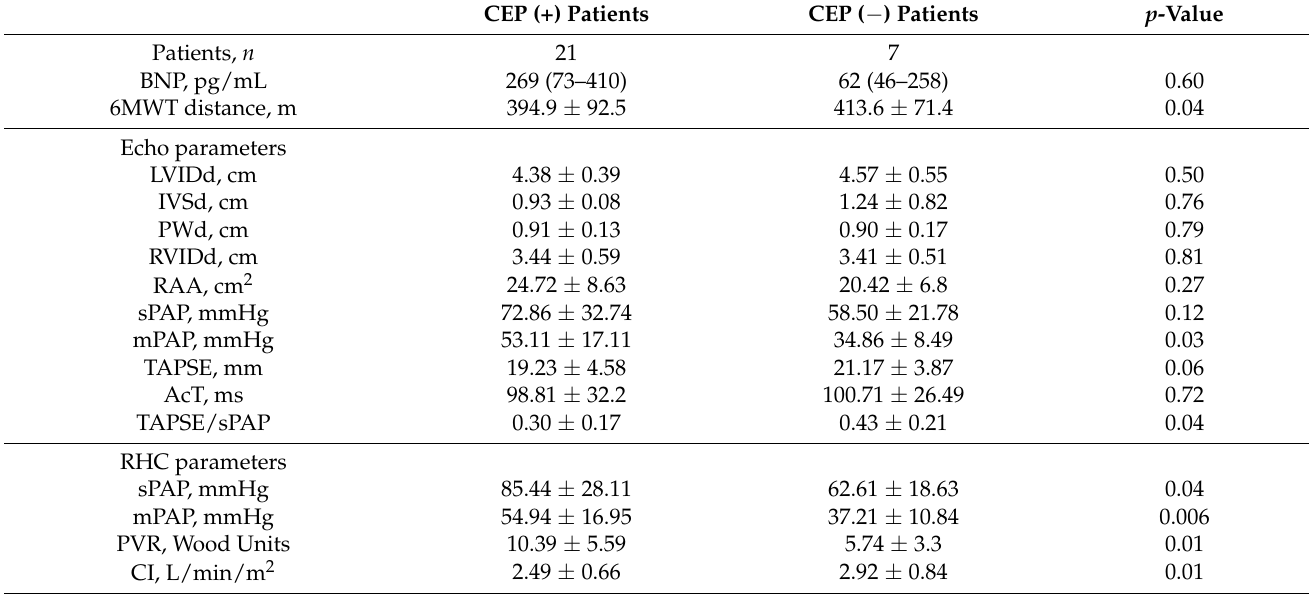
Table 2. Comparison of PAH patients with combined endpoint (CEP) and without CEP.